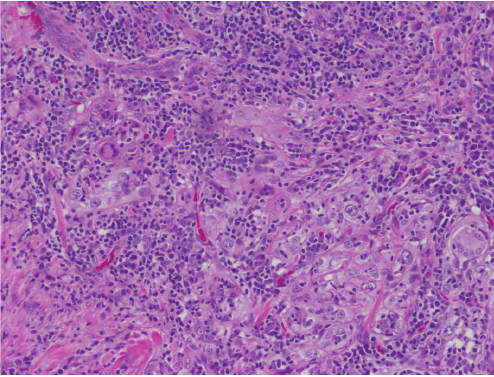
Figure 1: Hematoxylin and eosin stain (100x) showed aggregates of atypical epithelial cells and associated lymphoid tissue supported by fibrous connective tissue.